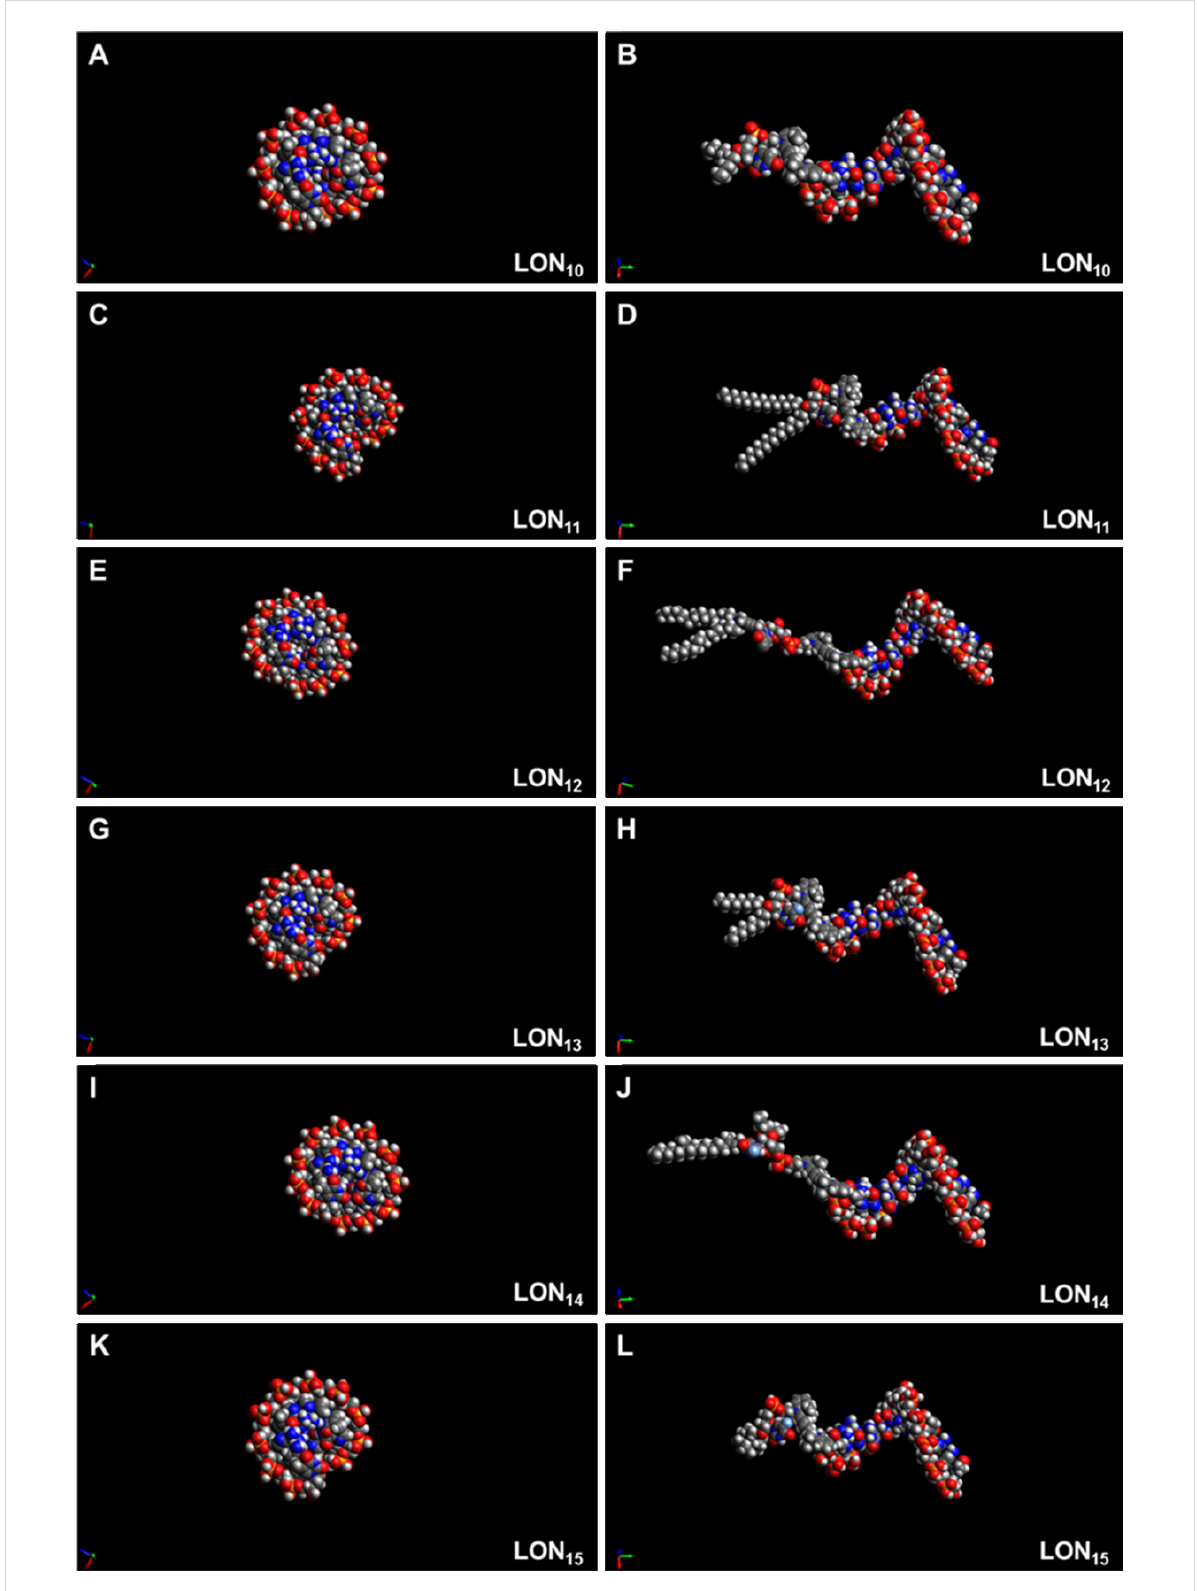
Figure 14: Hydrodynamic models of lipophilic oligonucleotides 10 – 15 . Views are perpendicular (right) or parallel (left) to the helix